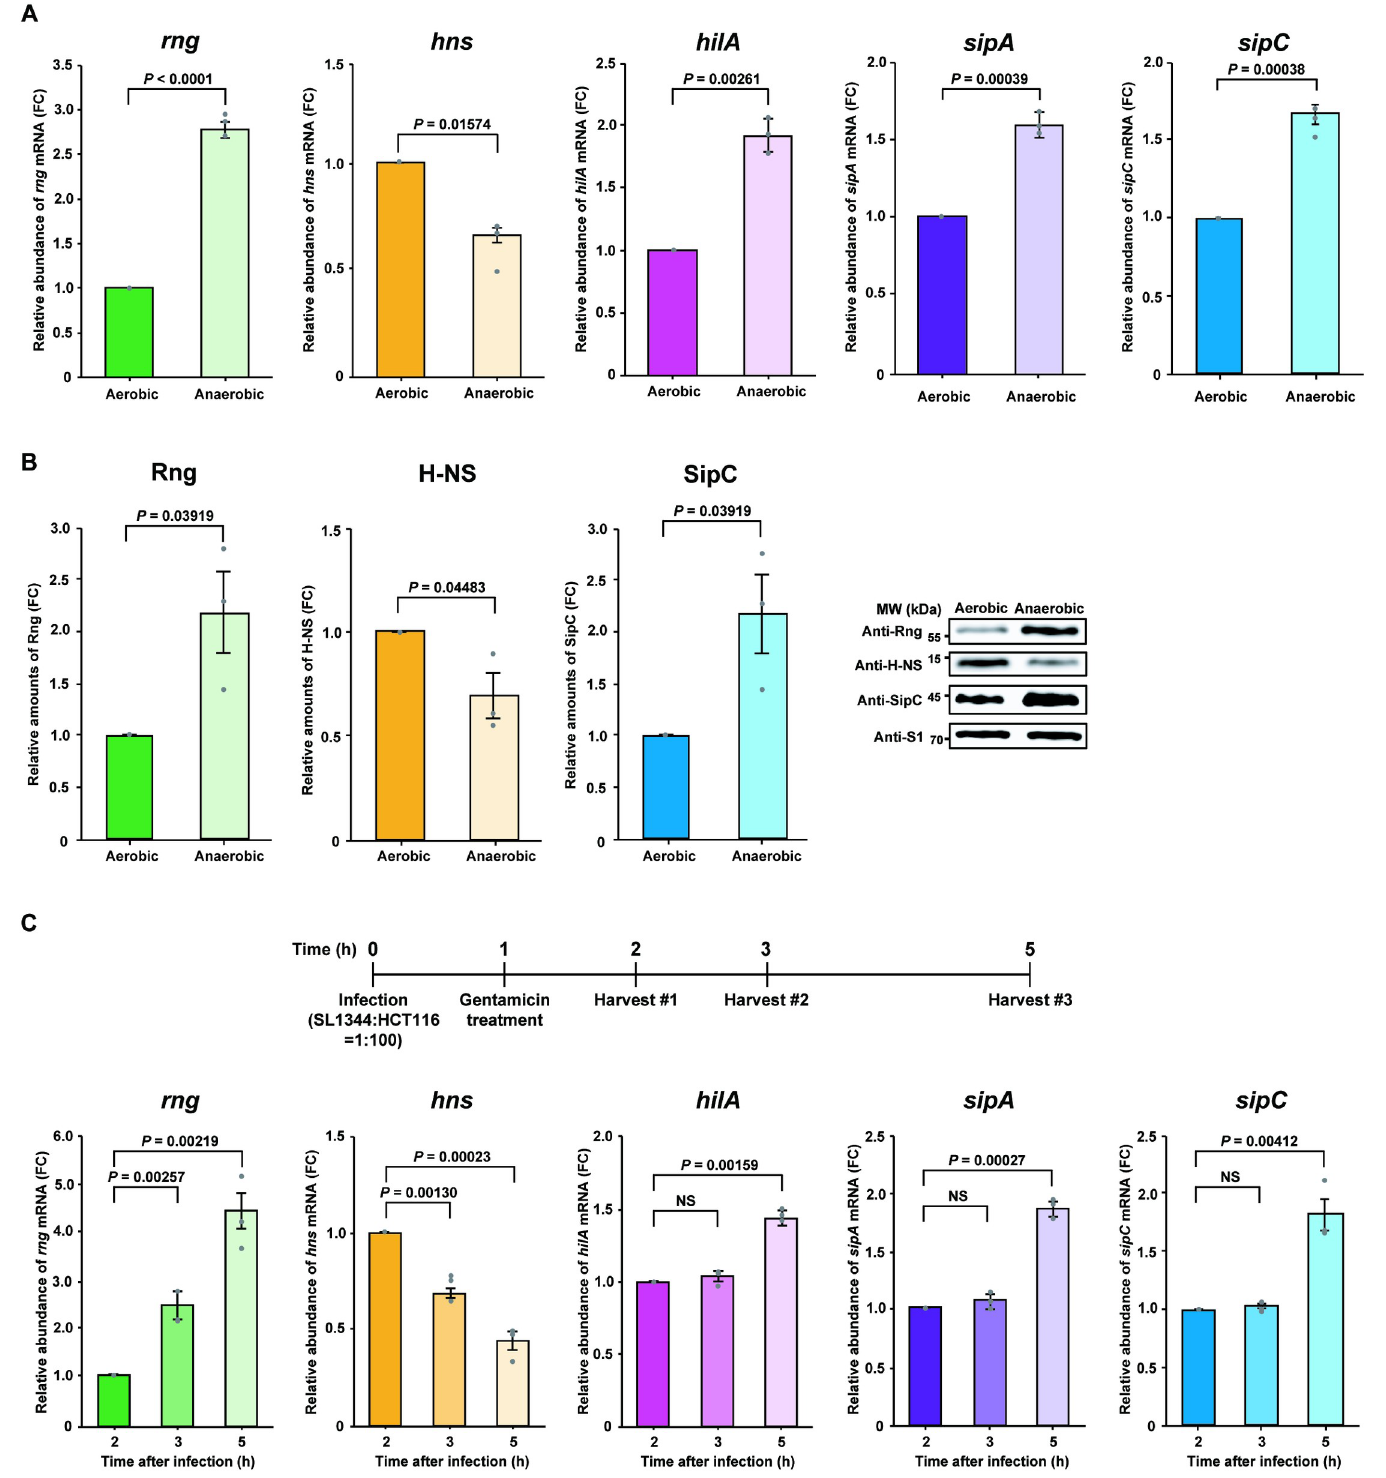
Fig 3. Effect of RNase G on SPI-1 T3SS. (A) Analysis of rng , hns , and SPI-1-related gene ( hilA , sipA , and sipC ) mRNA expression in WT S . Typhimurium under aerobic and anaerobic conditions by qRT-PCR. Expression levels of rng , hns , hilA , sipA , and sipC mRNA under aerobic conditions were set to 1. (B) Western blot analysis of Rng, H-NS, and SipC in the S . Typhimurium cultures used in (A). WT Rng, H-NS, and SipC levels under aerobic conditions were set to 1. Ribosomal protein S1 was used as an internal standard. (C) Analysis of rng , hns , and SPI-1-related gene ( hilA , sipA , and sipC ) mRNA expression in the infection stage by qRT-PCR. HCT116 cells were infected